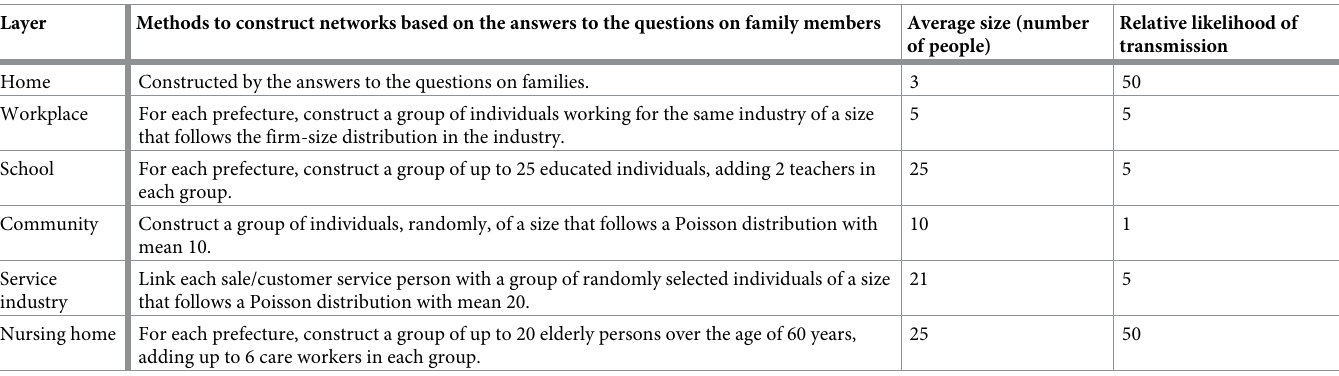
Table 4. Methods used to create the networks for each